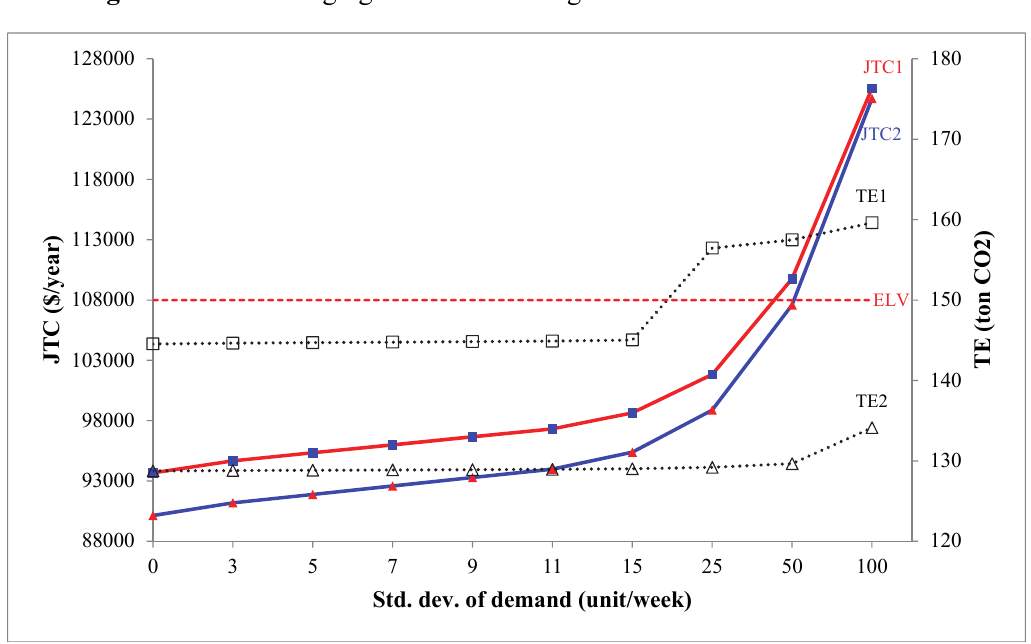
Fig. 9. Effect of changing in demand average on total cost and total emission